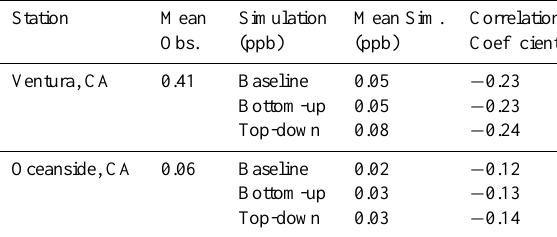
Table 2. Comparison of isoprene observations and simulations for two coastal PAMS stations from 1 June to 31 August 2005.